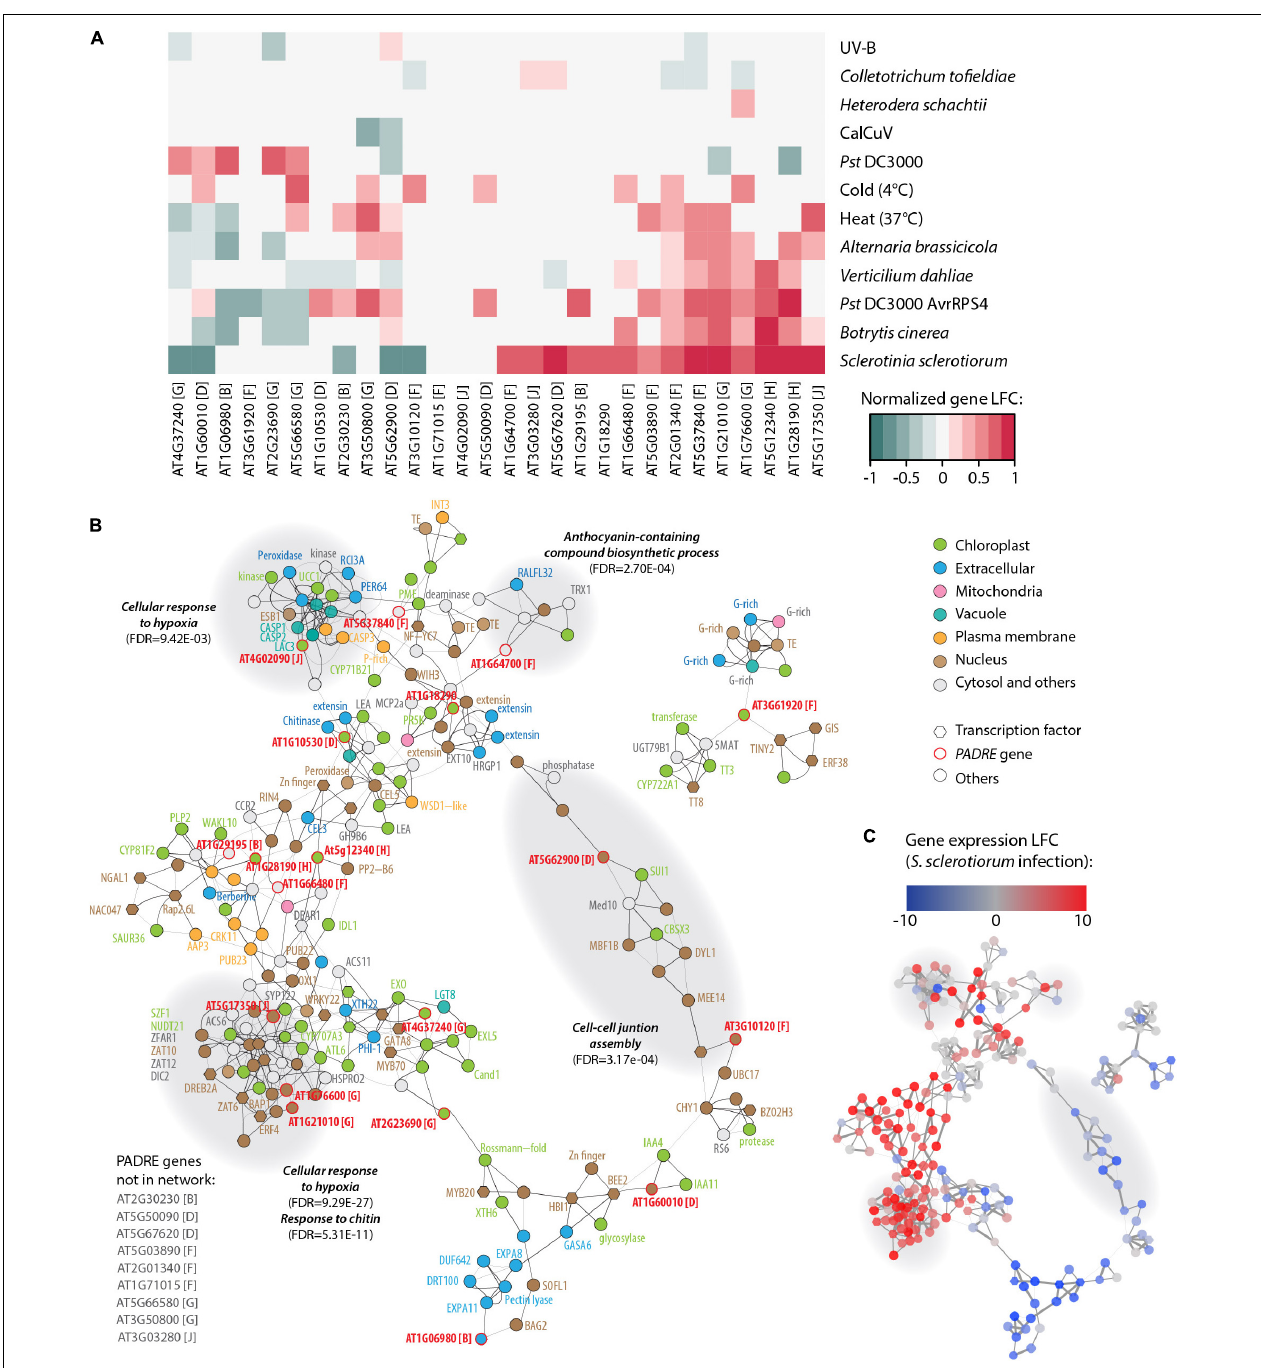
FIGURE 6 | Response to multiple pathogens and co-expression network for AtPADRE genes. (A) Expression profiles of A. thaliana PADRE genes under multiple biotic and abiotic stresses deduced from published RNA sequencing data. The expression levels of genes were normalized using min–max feature scaling to fit within the [–1; 1] range for all experiments. Non-significant LFCs are displayed as 0. The phylogenetic group of AtPADRE genes is given between square brackets. The associated raw data is available from GEO accessions GSE132169, GSE70094, GSE72548, GSE56922, GSE88798, GSE112225, GSE85653, GSE83478, GSE104590, GSE116269, GSE66290, and GSE106811. Pst , Pseudomonas syringae pv. tomato . (B) Co-expression network for AtPADRE genes deduced from an experiment of 14,668 microarrays. Nodes are color-coded according to subcellular localization predicted by WOLF-Psort, shown as hexagons for transcription factors and as circles otherwise. AtPADRE genes are outlined and labeled in red. Edge widths are scaled according to a mutual rank score index for co-expression. Gray-shaded areas show a subnetwork identified by network modularity analysis, with associated specific gene ontologies labeled in bold italics. (C) The same co-expression network as in (B) with nodes color-coded according to LFC of gene expression upon infection by S. sclerotiorum determined by RNA sequencing (GEO accession GSE106811). LFC, log 2 fold change of gene expression.